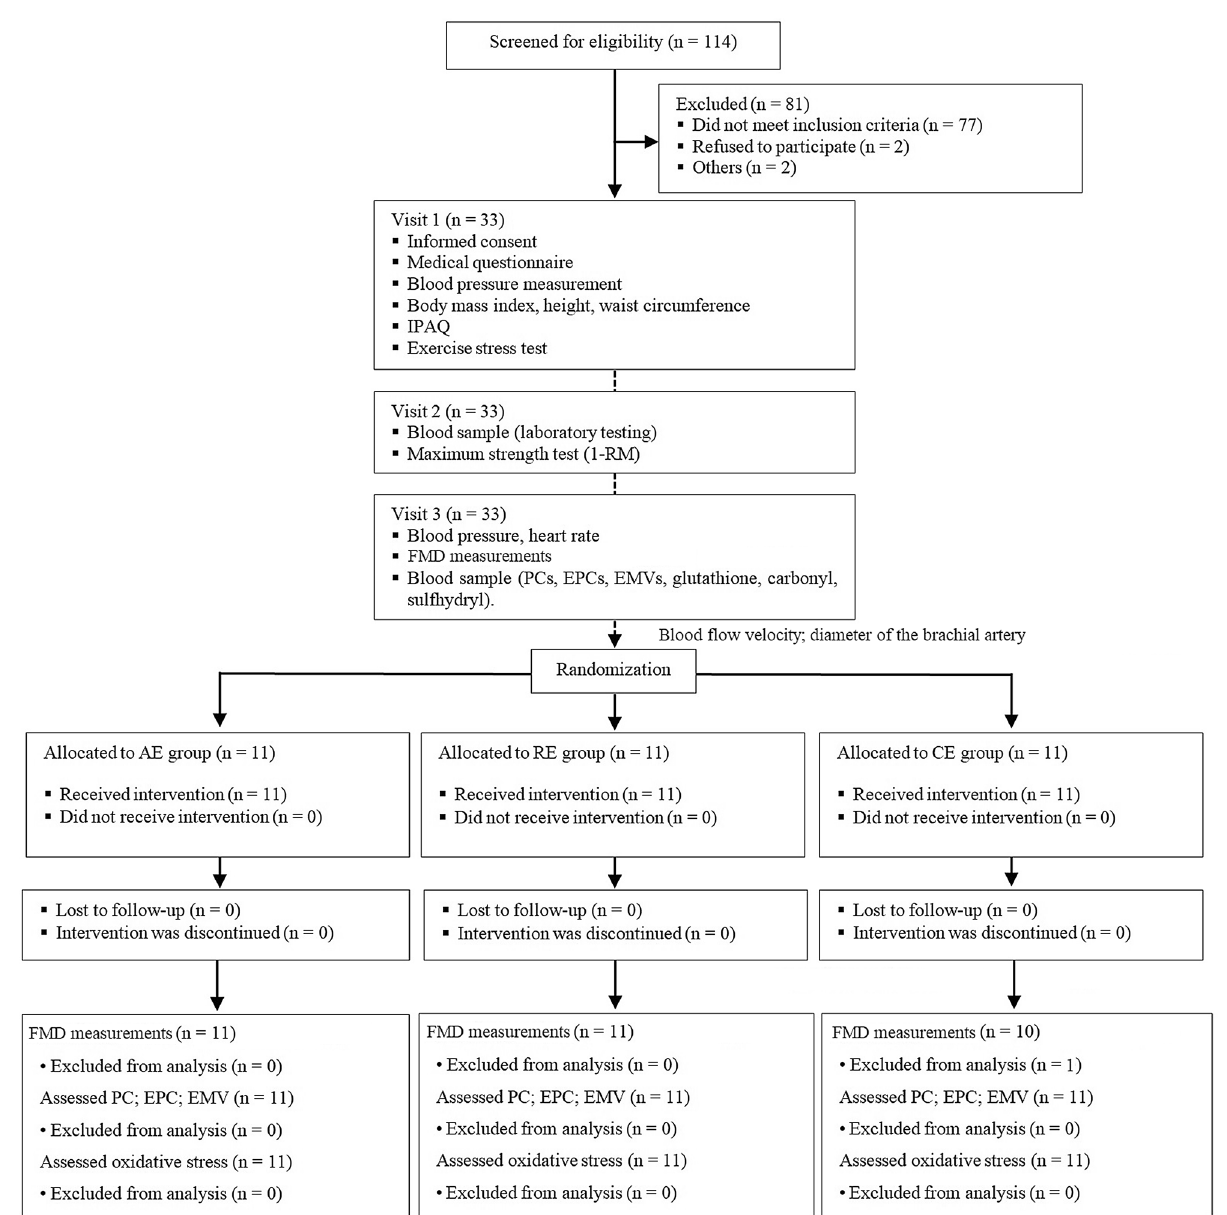
Figure 1. Study design. IPAQ, International Questionnaire of Physical Activity; FMD, flow-mediated dilation; PCs, progenitor cells, EPCs, endothelial progenitor cells, EMVs, endothelial microvesicles; AE, aerobic exercise session; RE, resistance exercise session; CE, combined exercise